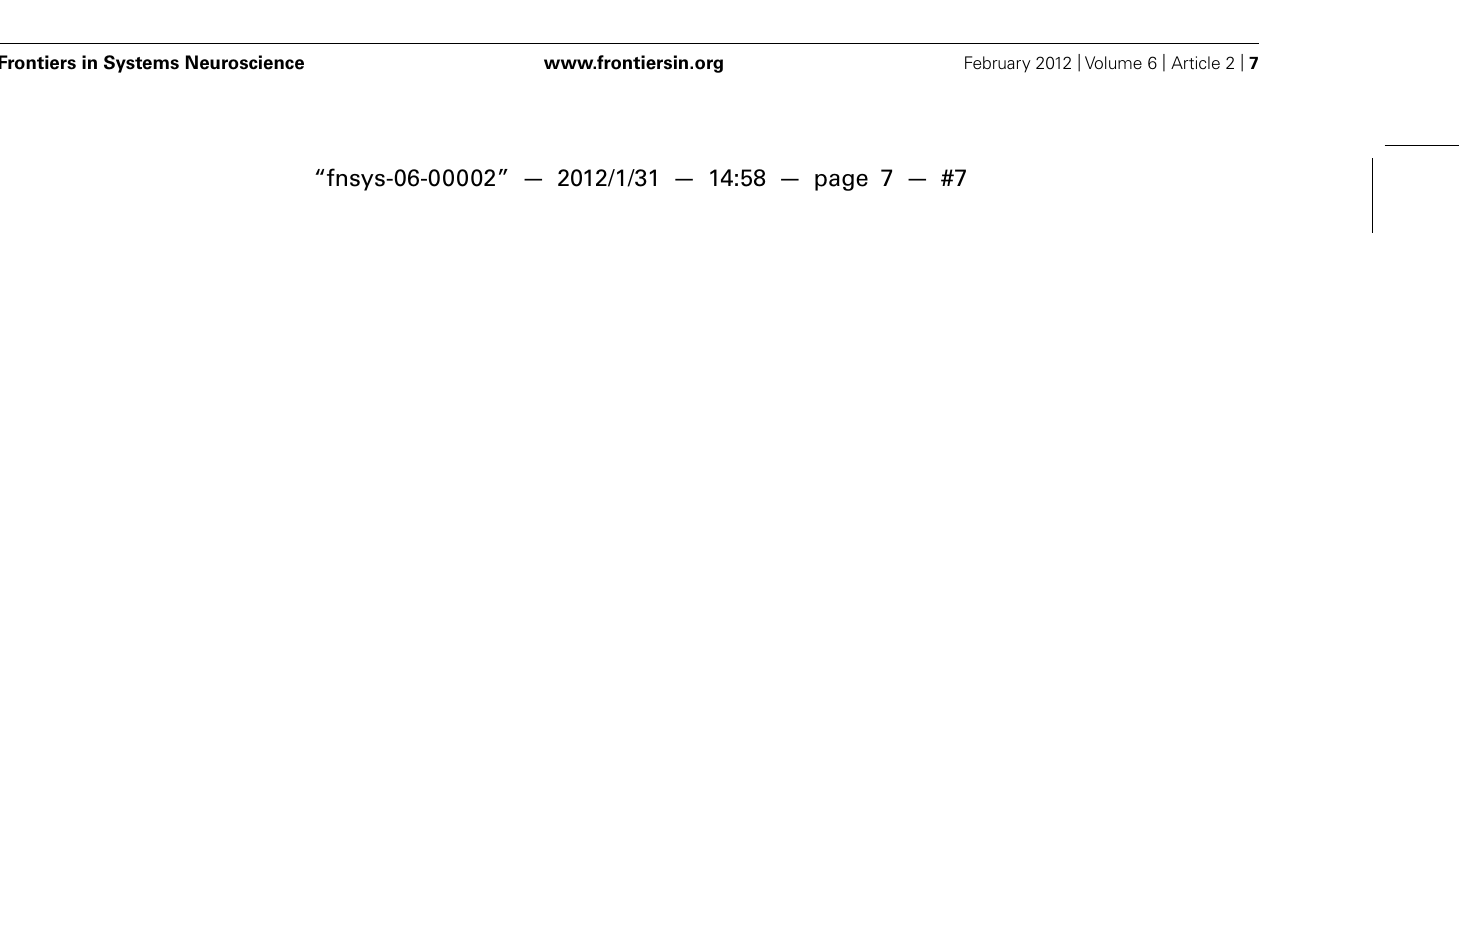
by Figure 2B ), whereas the second component’s spatial map